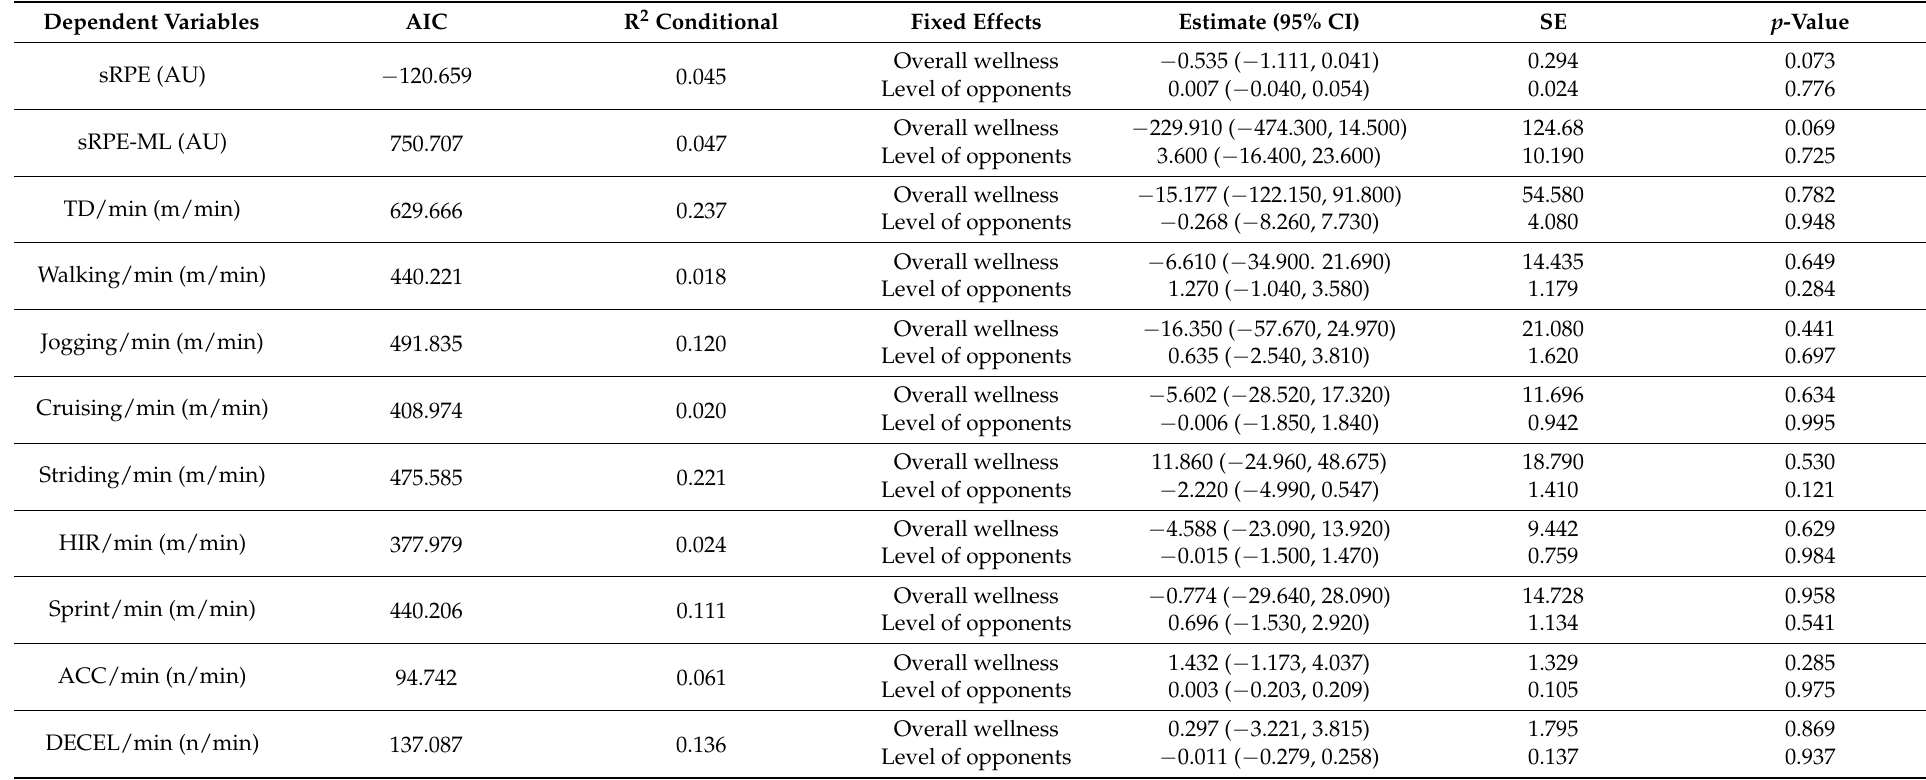
Table 4. Effect of previous-day overall wellness and level of opponents on match load